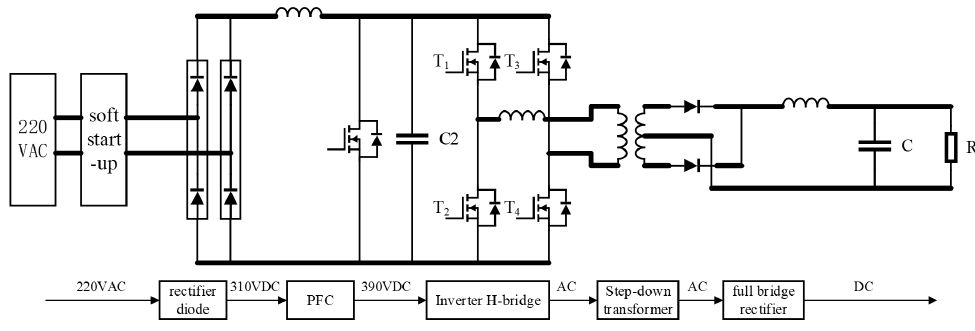
Figure 3. The topology of the module.